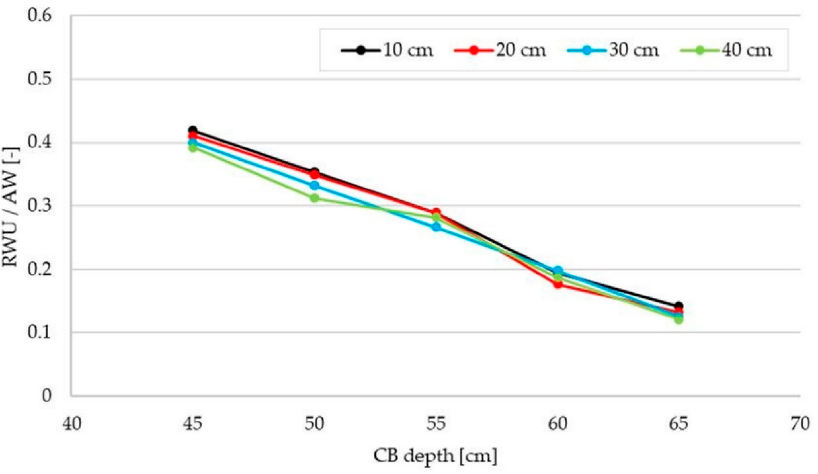
Figure 5. Cumulative RWU expressed as a fraction of AW during the 28-day simulations when the ring-shaped emitter and CB are at different depths. The results for different ring-shaped emitter depths (10, 20, 30, and 40 cm) are shown using lines of different colors.